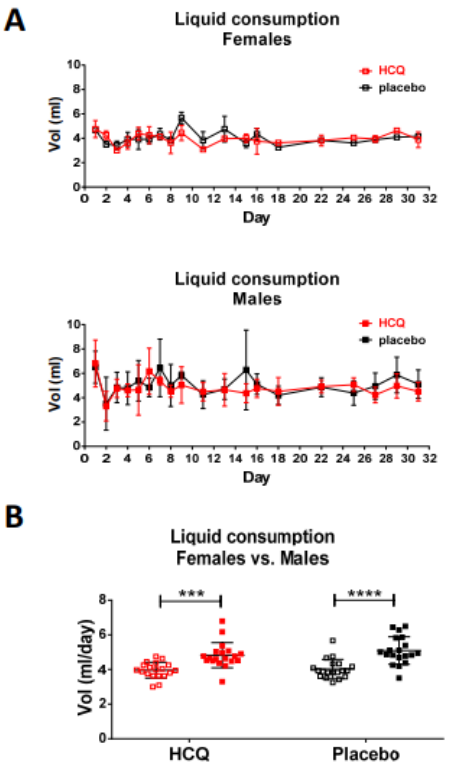
Figure 2. Daily fluid intake during HCQ treatment of Tg-D94A and NTg mice. ( A ) Daily liquid consumption of HCQ dissolved in drinking water (red symbols) vs. placebo/H 2 O (black symbols) by females (open symbols) and males (closed symbols). The placebo group comprised N ◦ = 6 females and N o = 6 males (3F and 3M mice per genotype), while the HCQ-treated group N o = 8 females and N o = 8 males (4F and 4M mice per genotype), with each gender housed in a separate cage. The volume of liquid consumption was recorded for each cage every day for the first 9 days of the experiment and then every 2–4 days, divided by the number of mice per cage and the interval between measurements, and further averaged per gender. The graphs in ( A ) show the average daily intake per animal. ( B ) Averaged liquid consumption per mouse per day. Open symbols represent female mice and closed-male mice. Data are presented as the mean ± SD. Statistical significance was assessed by two-way ANOVA followed by Sidak’s multiple comparison test and depicted as *** p < 0.001 and **** p < 0.0001 for female vs. male